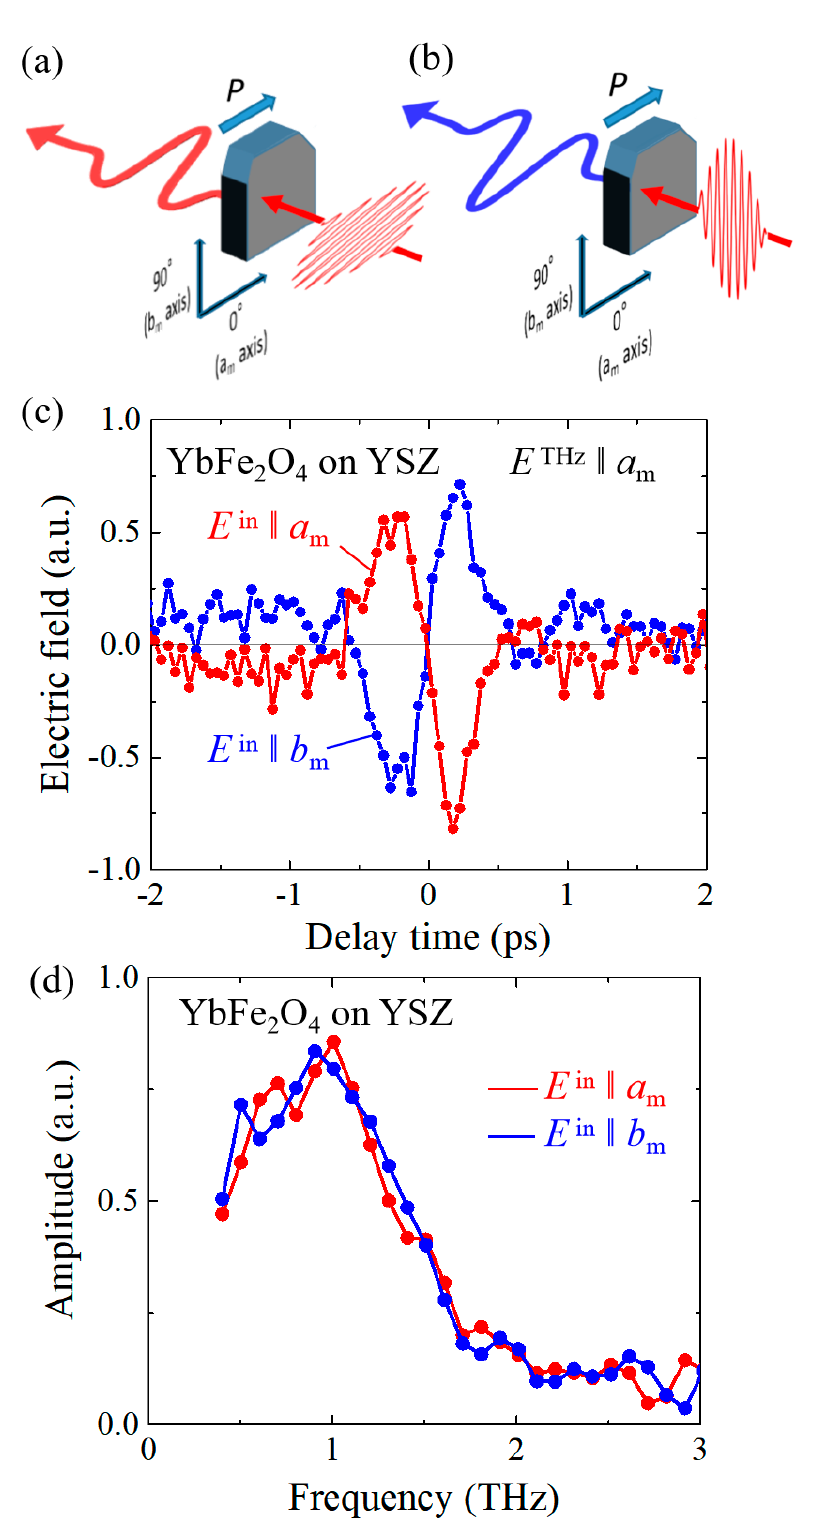
Figure 5. ( a , b ) Schematics to illustrate the relationship of the polarization of the 800 nm pulse and that of generated terahertz pulse. ( c ) Waveforms of the terahertz pulse emitted in the direction of a m axis from YbFe 2 O 4 thin film. The red (blue) circles denote the terahertz pulse generated when the polarization of the incident fundamental pulse ( E in ) is set along the a m ( b m ) axis. ( d ) Amplitude spectra calculated by Fourier transform analysis from the waveforms in Figure 5c.